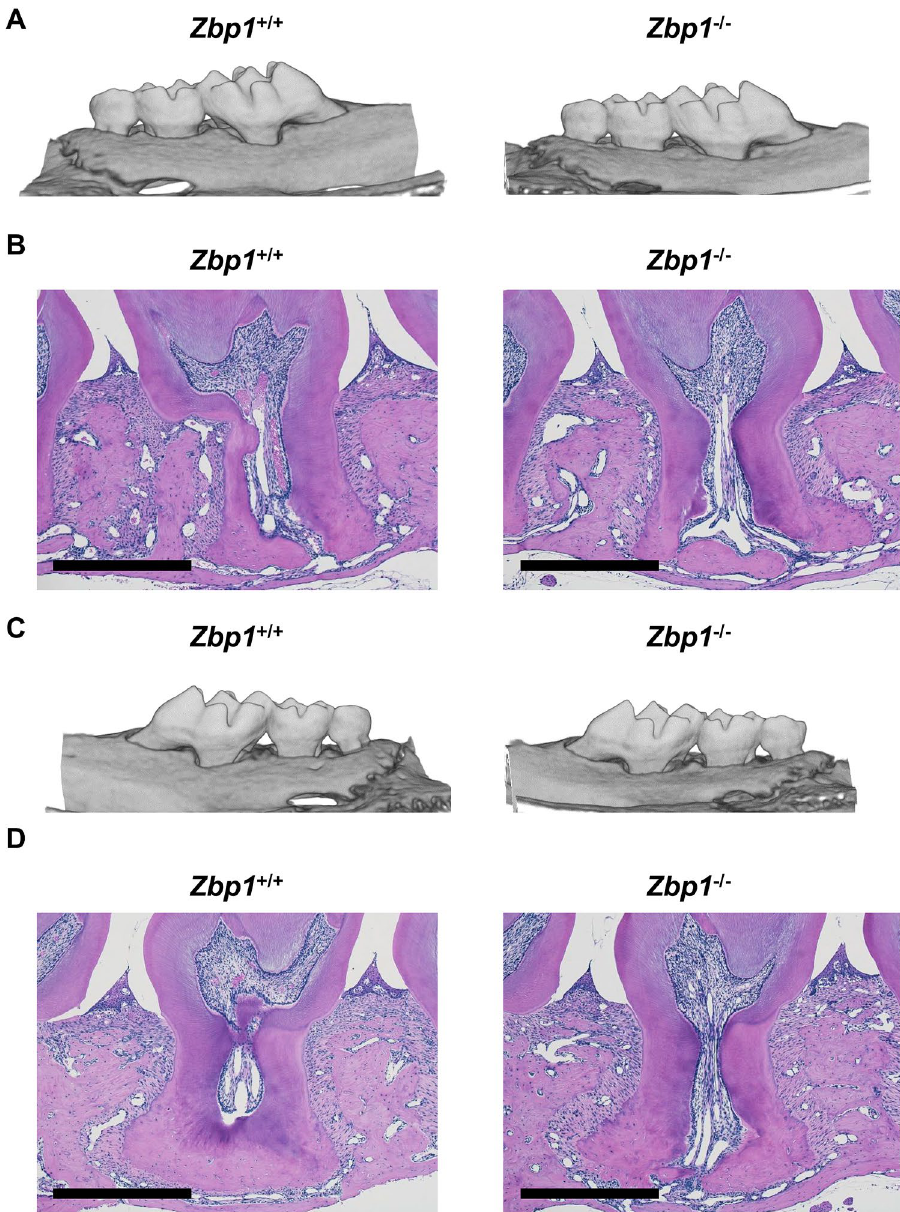
Figure 6. Analysis of Zbp1 KO mice. ( A ) The representative micro-CT images of intact maxillae of 10-week- old Zbp1 KO and WT mice. ( B ) The representative HE staining images of intact maxillary left second molar of 10-week-old Zbp1 KO and WT mice. ( C ) The representative micro-CT images of repaired maxillae of 10-week- old Zbp1 KO and WT mice. ( D ) The representative HE staining images of repaired maxillary left second molar of 10-week-old Zbp1 KO and WT mice. Scale bar: 500